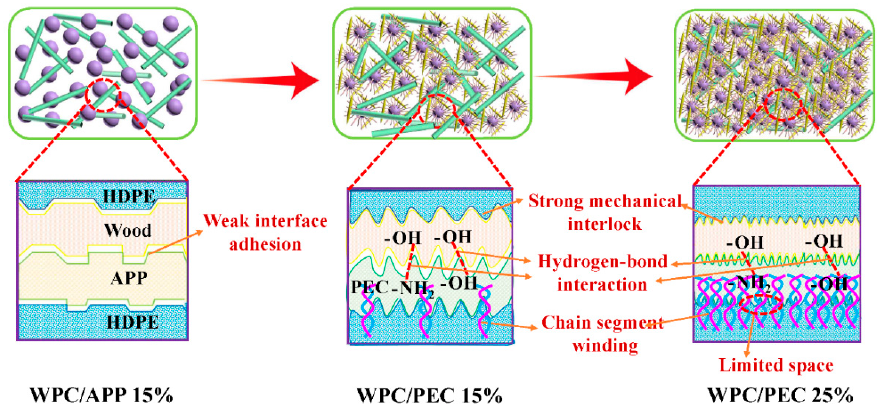
Figure 8. PEC distribution within WPC and possible interfacial bonding mechanisms.